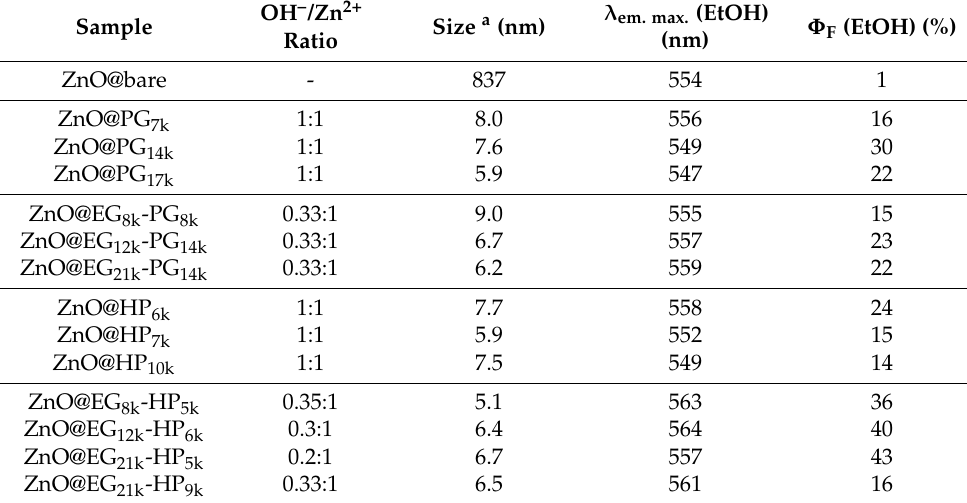
Table 2. Synthetic conditions, hydrodynamic diameter, and photophysical properties of hybrid ZnO QDs synthesized in the presence of multihydroxylated polymer